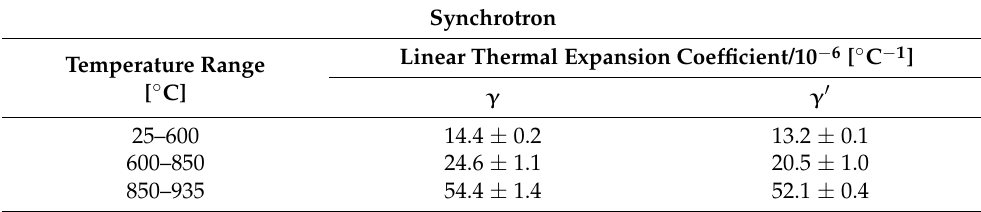
Table 4. Linear thermal expansion coefficient of the different phases determined by synchrotron XRD in the three different temperature ranges.